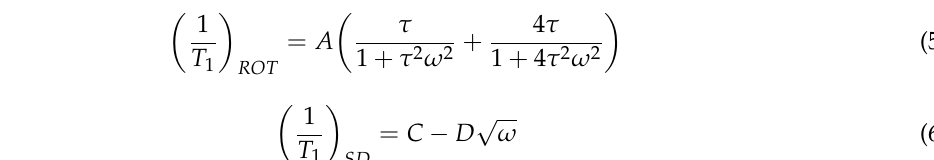
Figure 7. Frequency (MHz) dependence of proton spin-lattice relaxation time T 1 (s) of 9/2 RS/RS at some chosen temperatures in the three mesophases: isotropic, isotropic’, and cubic